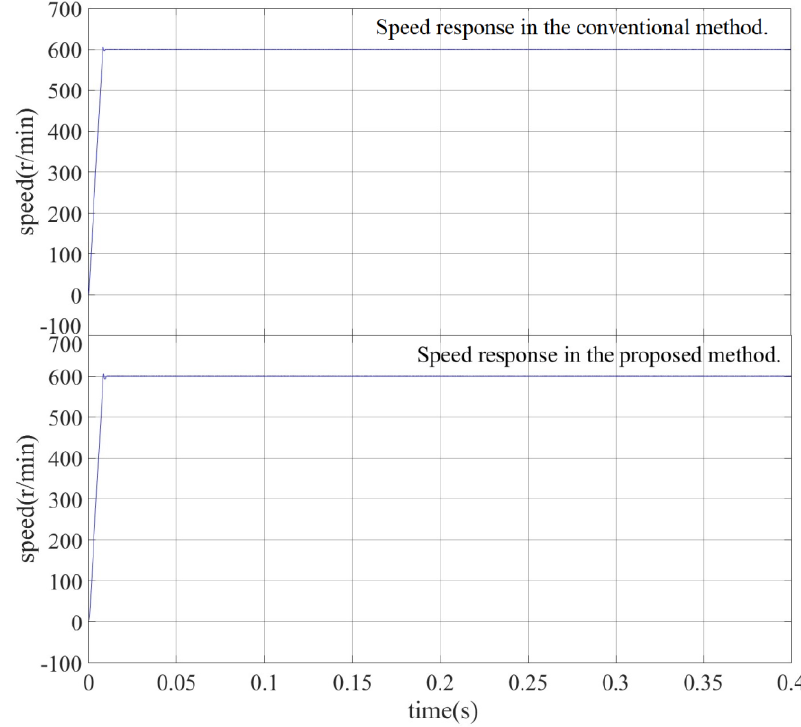
Figure 13. Speed response when the motor is in an approximately no-load state.